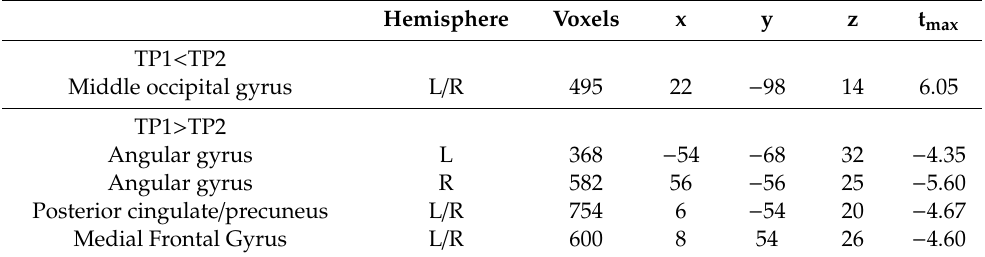
Table 2. Activation di ff erences in executive decision-making (regressor 1) between TP1 and TP2. Hemisphere Voxels x y